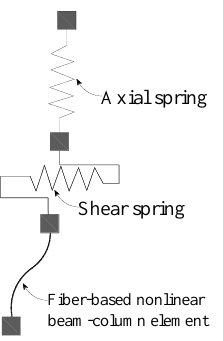
Figure 1. Model method of axial and shear behaviors of column [17].